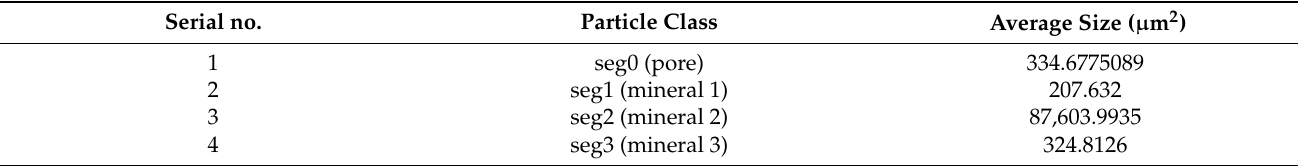
Table 9. Average size of each particle in total